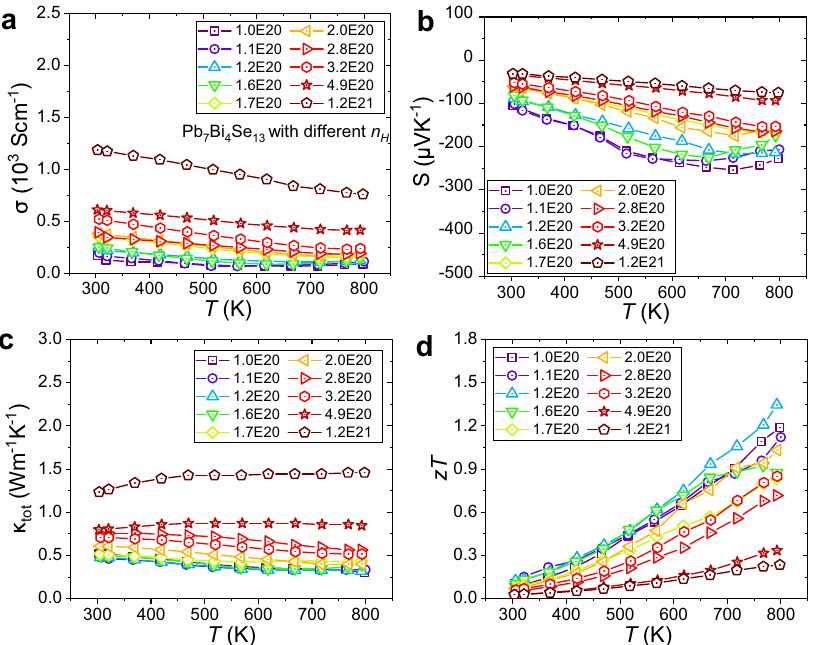
Fig. 1 Thermoelectric properties. a Electrical conductivity, b Seebeck coef fi cient, c total thermal conductivity, and d dimensionless fi gure of merit, zT